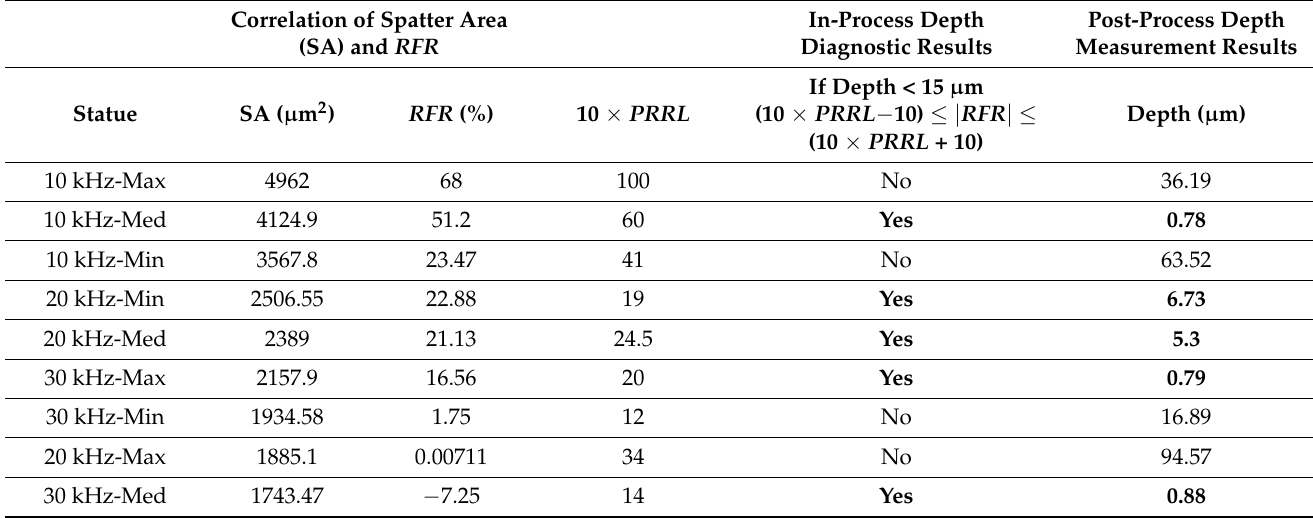
Table 3. RFR of the received RF power, calculated PRRL × 10 based on laser properties ( RRL and PL ) and measured SA and depth by 3D microscope for 9 states of laser hole ablation, from the maximum RFR and SA at the top to the minimum at the bottom of the table, together with the in-process depth diagnostic results. The depth lower than 10 µ m are